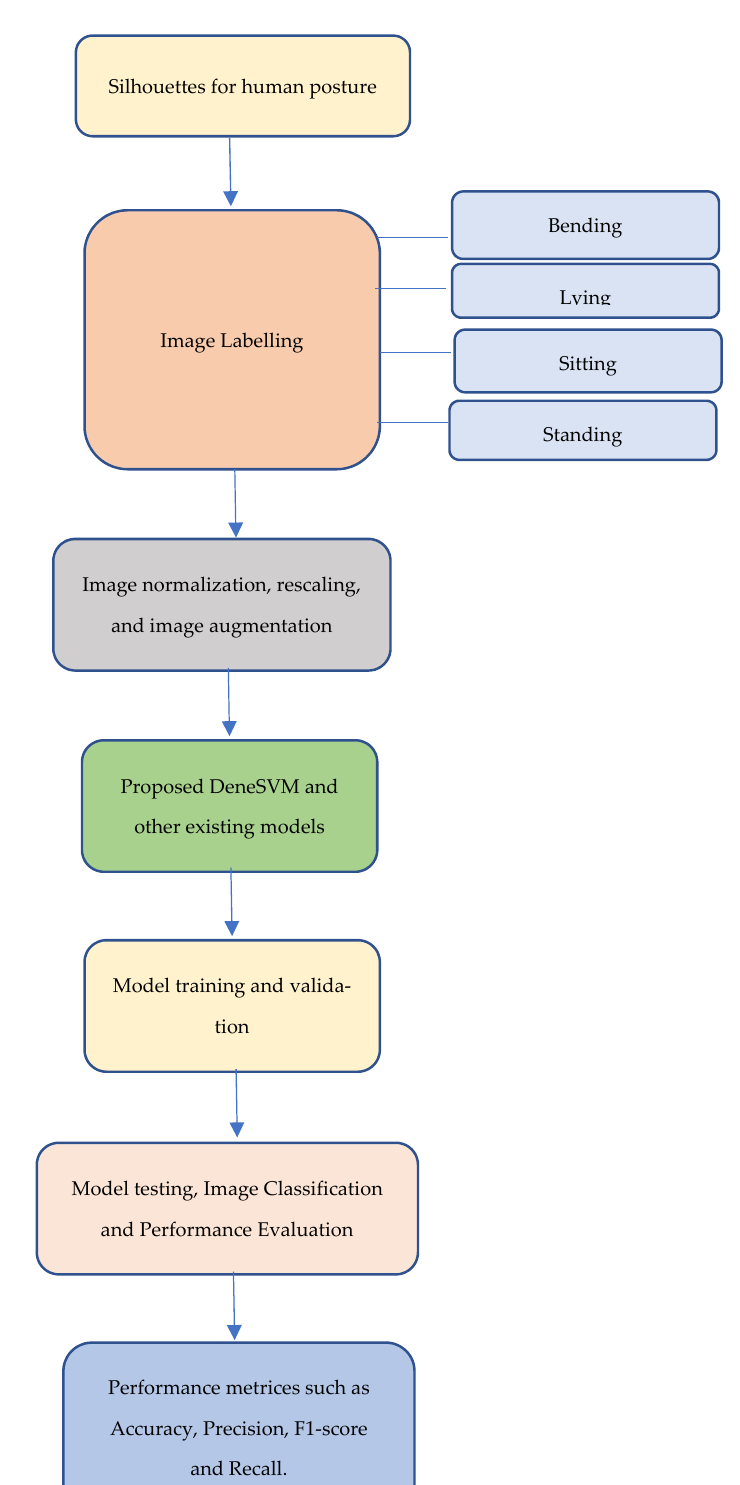
Figure 2. The proposed system flow using the Human Posture Images.